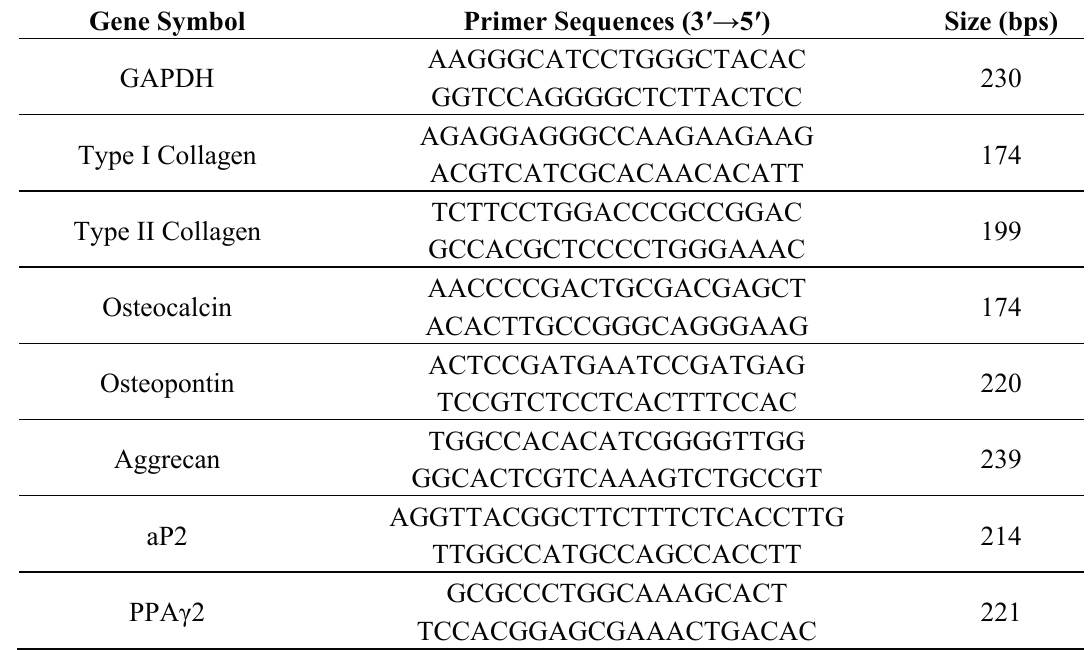
Table 2. Sequences of primers used in real-time